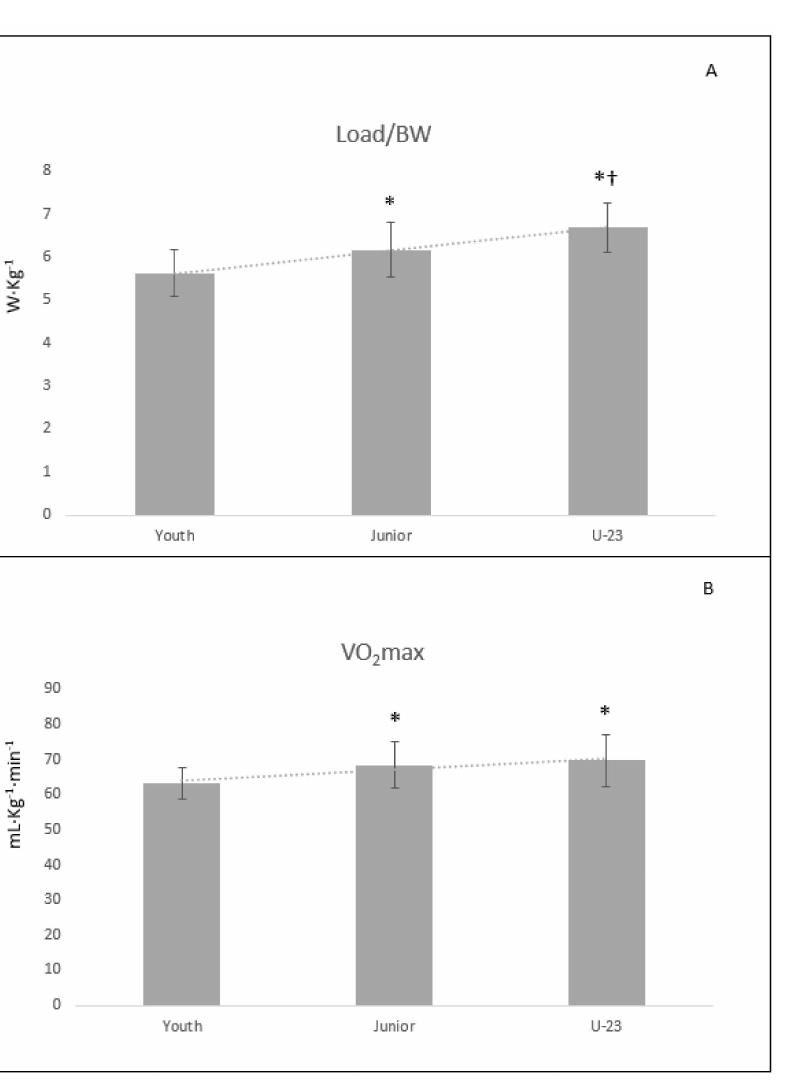
Figure 1. Maximal oxygen uptake ( A ) and Load/BW ( B ) values. Load/BW ( A ) = work load normalized to body weight; VO 2 max ( B ) = maximal oxygen uptake; * = Significant differences with Youth group; † = Significant differences with Junior